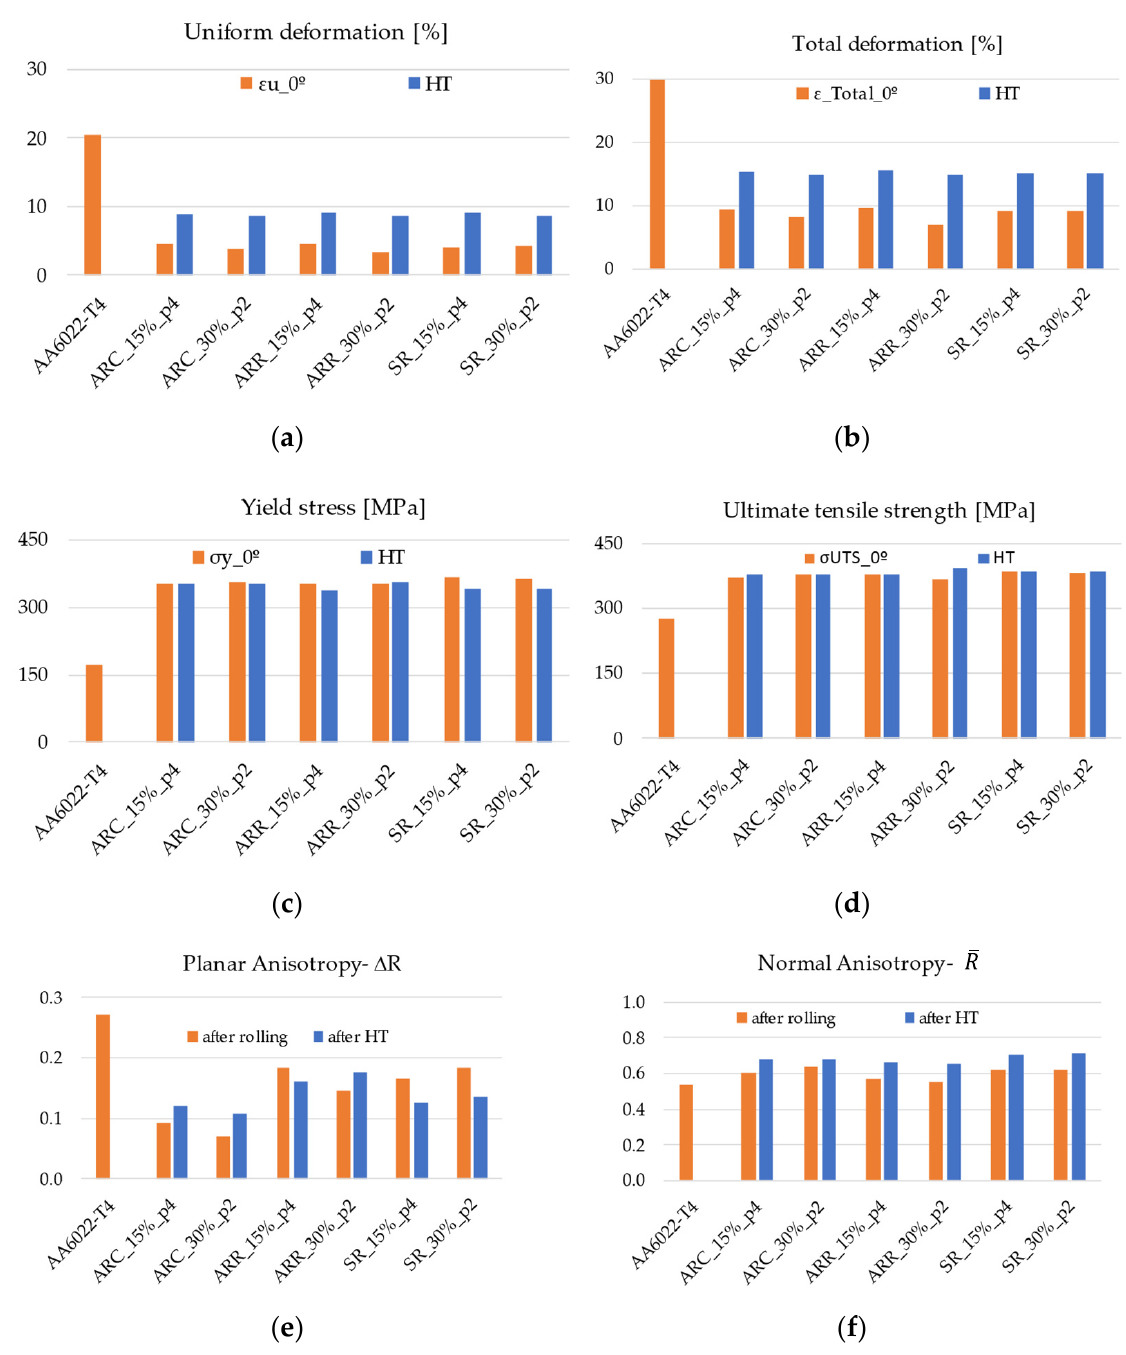
Figure 13. Effect of annealing in mechanical properties of rolled material.